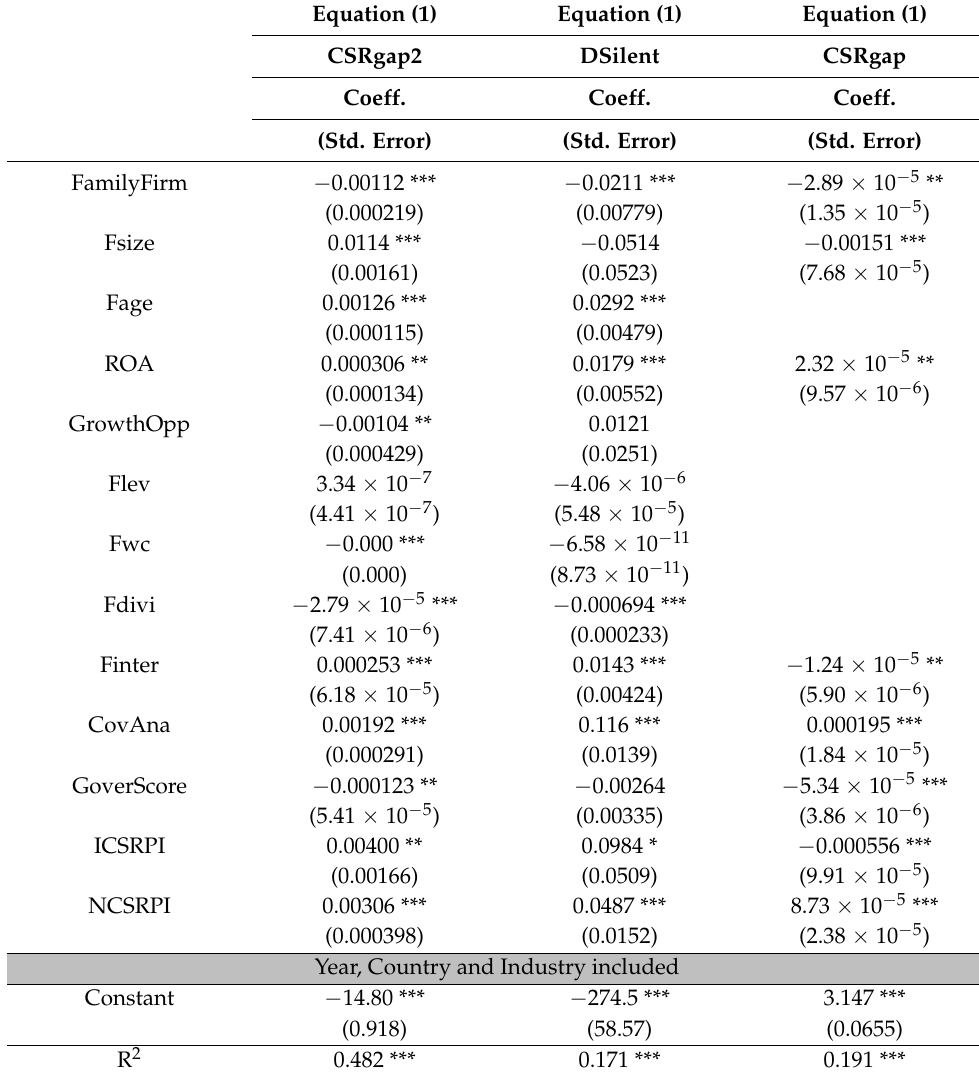
Table 5. Robust models (*** p < 0.01, ** p < 0.05, * p <